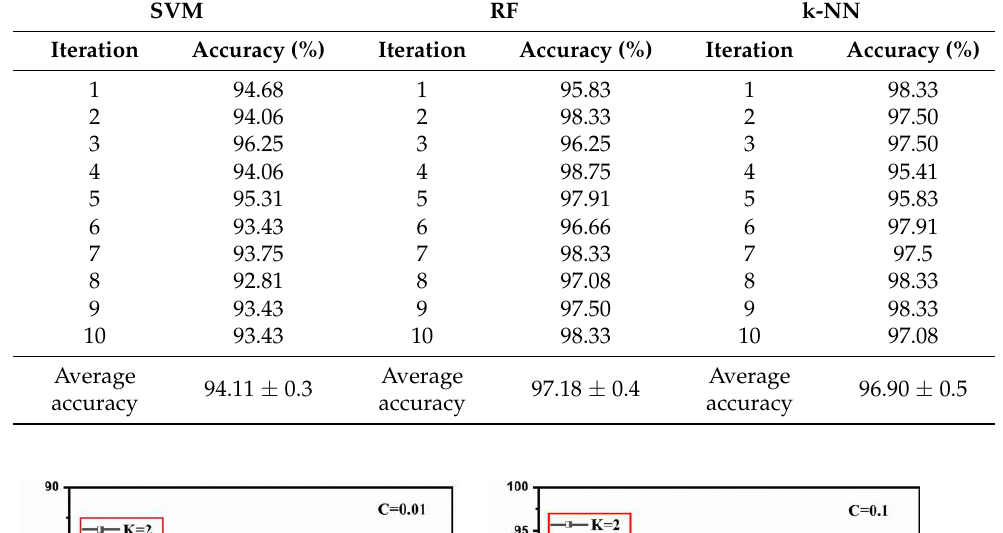
Table 1. Accuracy percentage 10-fold cross-validation for each fold.